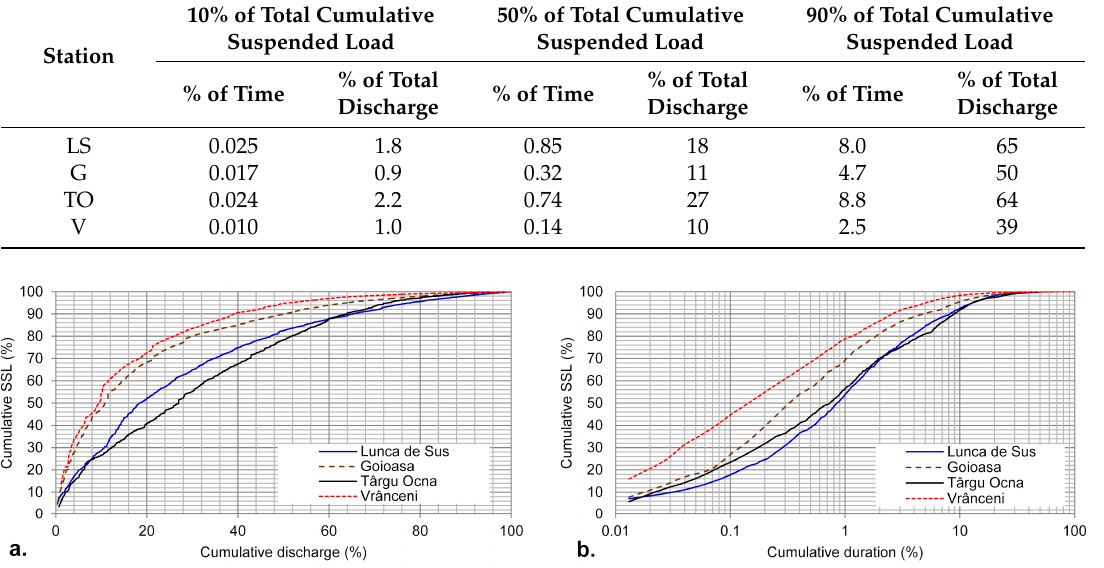
Figure 10. Cumulative percentage of suspended sediment load versus discharge ( a ) and time duration ( b ) (period 1994–2014).